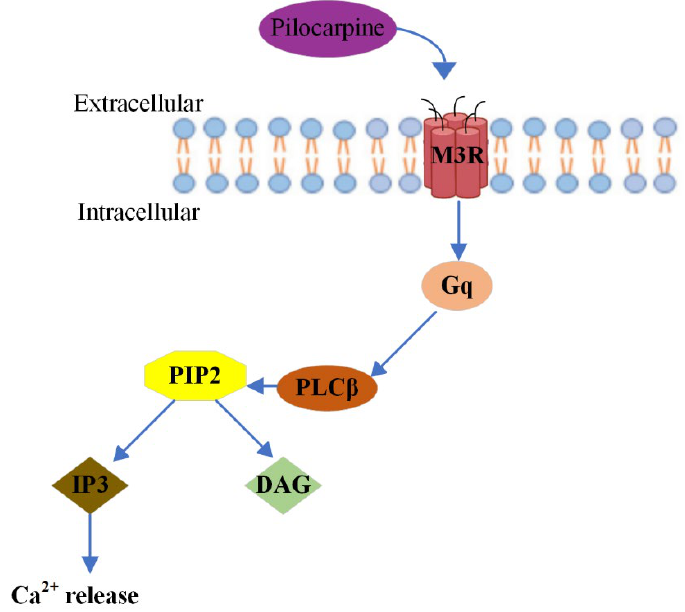
Figure 3. Illustration of Pilocarpine’s mechanism of action.